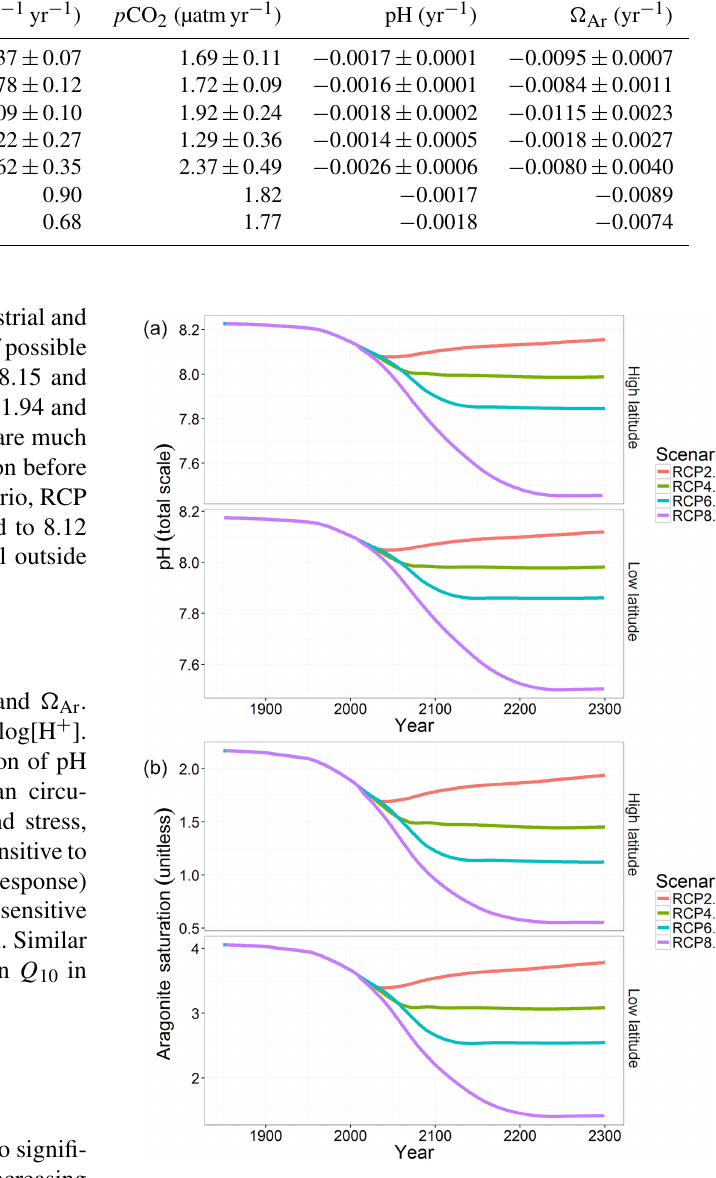
Figure 6. High- and low-latitude (a) pH and (b) aragonite saturation ( (cid:127) Ar ) time series for Hector from 1850–2300 for RCP 2.6 (red), RCP 4.5 (green), RCP 6.0 (teal), and RCP 8.5 (purple). Note that even under a strongly mitigated scenario (RCP 2.6), both (cid:127) Ar and pH at 2300 are still lower than preindustrial